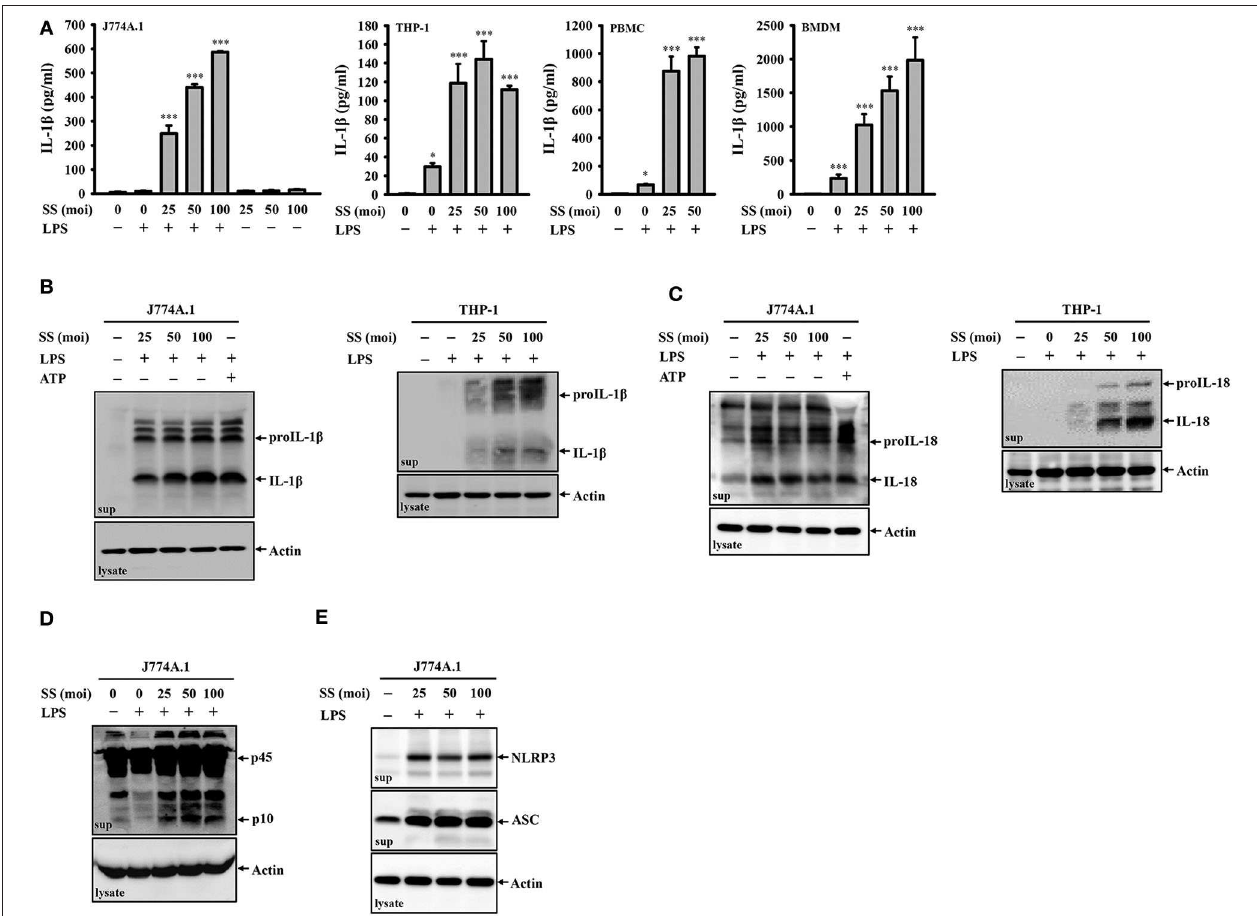
FIGURE 1 | S. sonnei induces the secretion of IL-1 β , IL-18, NLRP3, ASC, and active caspase-1 in macrophages. (A) J774A.1 macrophages, THP-1 macrophages, PBMCs or BMDM were primed with 1 µ g/ml LPS for 4h and then infected with S. sonnei for an additional 20h. The levels of IL-1 β in the supernatants were measured by ELISA. (B–E) J774A.1 macrophages or THP-1 macrophages were primed with 1 µ g/ml LPS for 4h followed and then infected with S. sonnei for an additional 20h or stimulated with 5mM ATP for an additional 0.5h. The levels of IL-1 β (B) , IL-18 (C) , caspase-1 (D) , NLRP3, and ASC (E) in the supernatants were measured by Western blotting. The ELISA data are expressed as the mean ± SD of four separate experiments. The Western blotting results are representative of three different experiments. * and *** indicate significant differences at the levels of p < 0.05 and p < 0.001, respectively, compared to untreated control cells (one-way ANOVA with Dunnett’s multiple comparisons